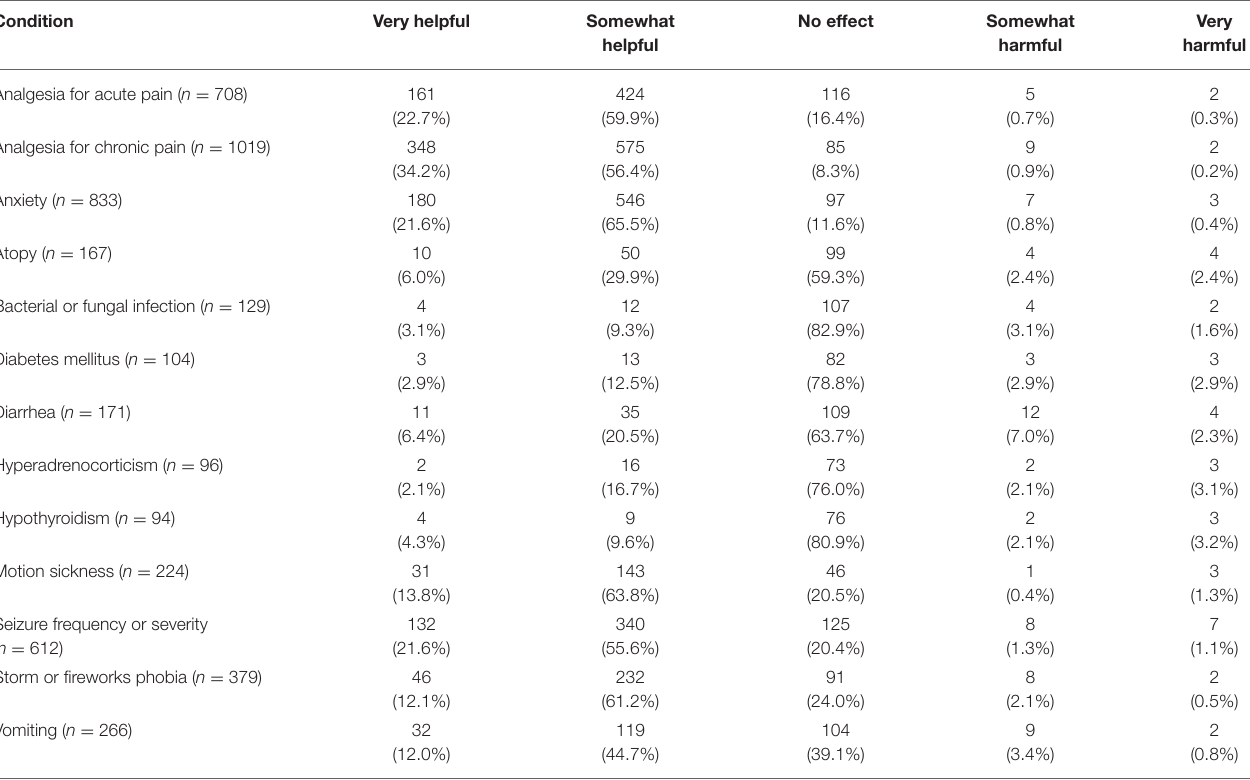
TABLE 5 | Perceived impact of CBD products for common canine medical conditions, listed